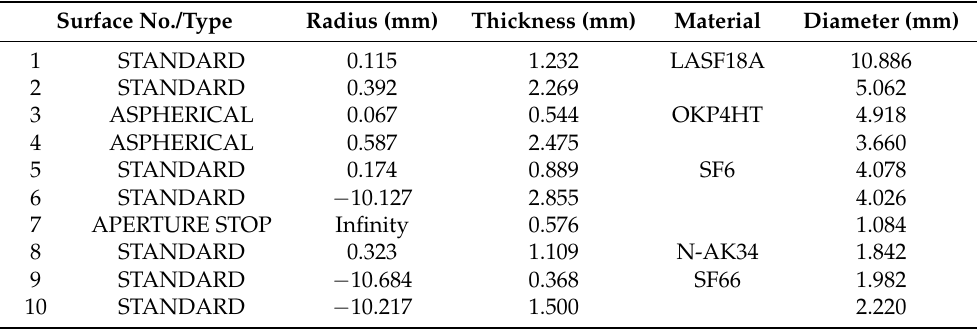
Table 2. Lens data of a miniaturized wide-angle fisheye lens using an OKP4HT aspherical lens and four glass spherical